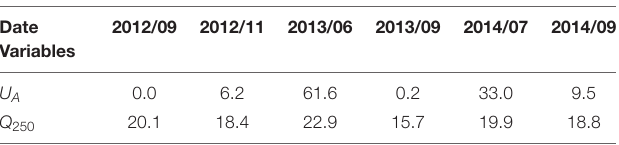
TABLE 1 | The estimated coastal uplift area ( U A ; km 2 ), water volume transport